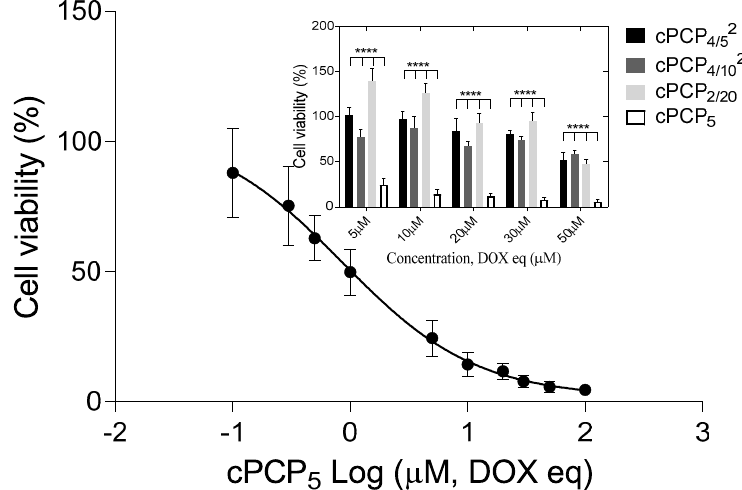
Figure 4. HT1080 cell viability after 72 h of incubation with increasing concentrations of cPCP 5 . Calculated IC 50 was 0.86 μ M (DOX eq). This result comes from three separated experiments done in triplicates (n = 9). The histogram presented in the top-right corner shows the comparison of the cytotoxicity results in cells incubated for 72 h with increasing concentrations of cPCP 4/52 , cPCP 4/102 , cPCP 2/20 and cPCP 5 . (**** p < 0.0001).